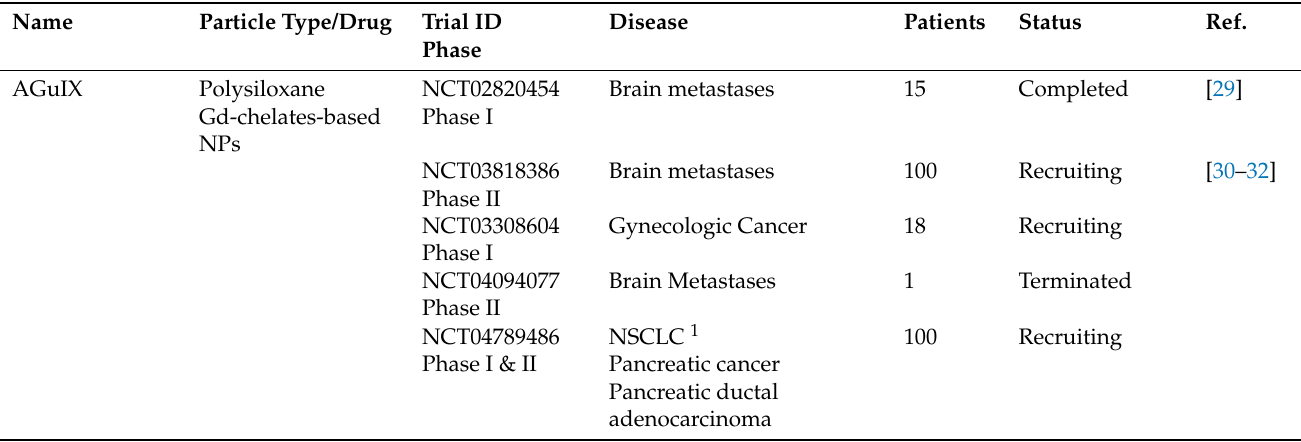
Table 1. Clinical trials of the nano-radioenhancers